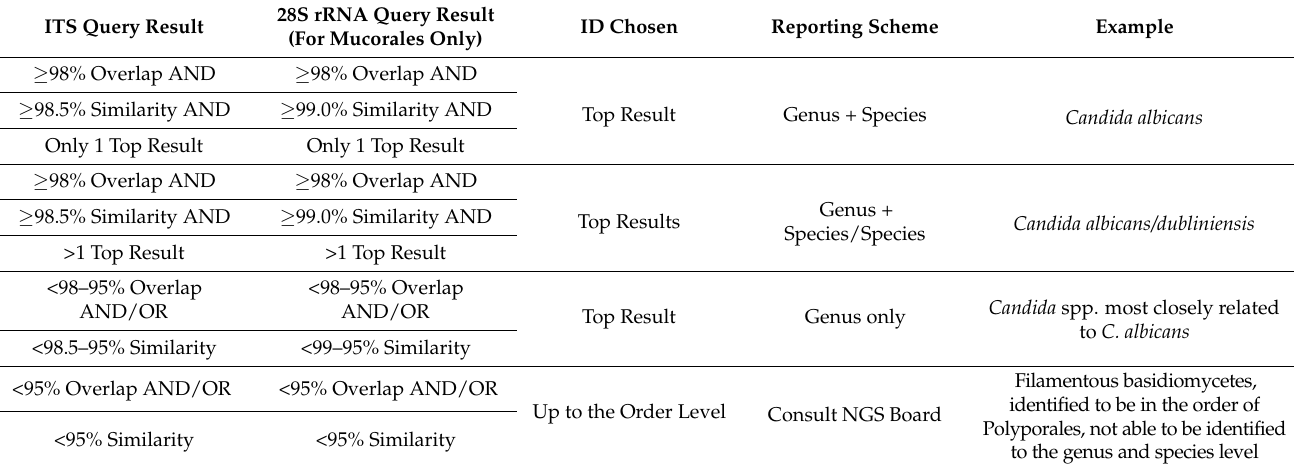
Table 1. Reporting Scheme Used Following Query of the Westerdijk Fungal Biodiversity Institute